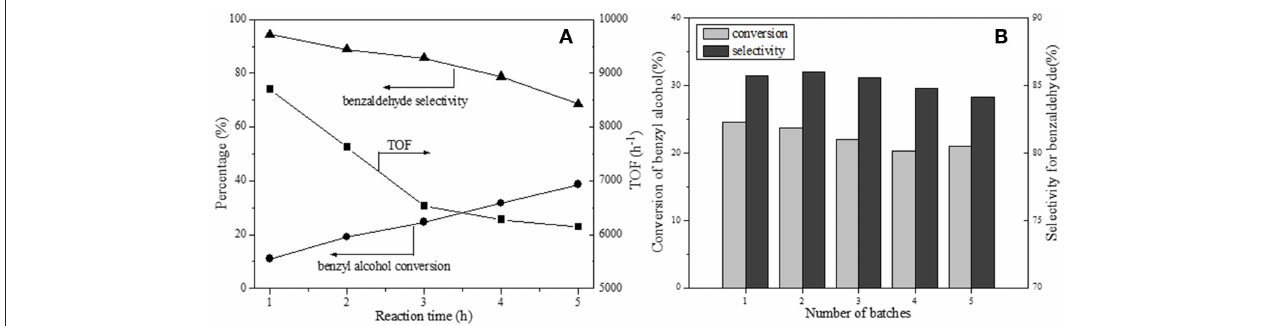
FIGURE 8 | Time course (A) and recycling ability (B) of 1Pd/NOMC-0.3-750 for benzyl alcohol oxidation. Reaction conditions: catalyst, 20mg; benzyl alcohol, 50 mmol; O 2 , 20 mL/min − 1 ; temperature, 160 ◦ C; reaction time,